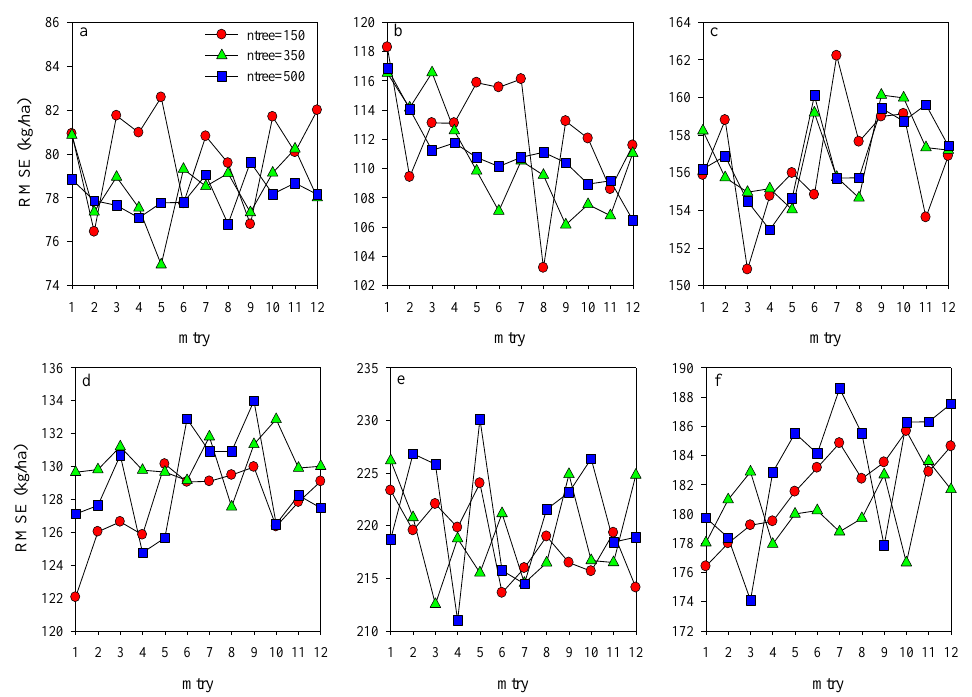
Figure 6. Optimization of random forest parameters (ntree and mtry) using RMSE at different growth stages for training dataset ( a – c represent the Opt-SIs coupling with RF algorithm at ( a ) tuber formation, ( b ) tuber bulking, and ( c ) the combined stage; ( d – f ) represent the full spectrum coupling with RF algorithm at ( d ) tuber formation, ( e ) tuber bulking, and ( f ) the combined stage.).